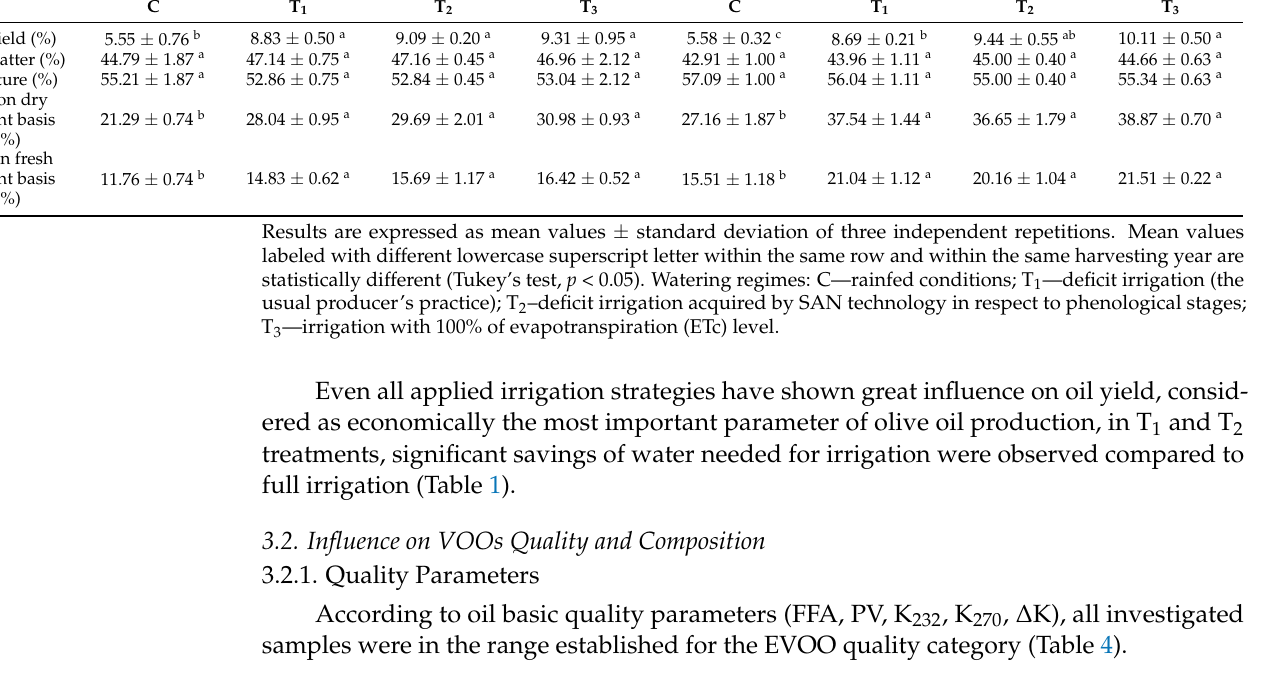
Table 4. Quality parameters (peroxide value—PV; free fatty acids—FFA; spectrophotometric indices— K 232 , K 270 and ∆ K) of virgin olive oils from Coratina cv. olive trees grown under different watering regimes during two crop seasons (2019 and